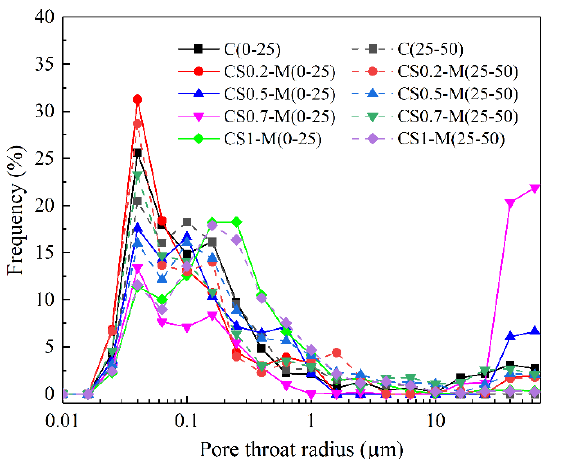
Figure 14. Pore distribution at 0–25 mm and 25–50 mm after 360 d erosion by NaCl-MgSO 4 solution.